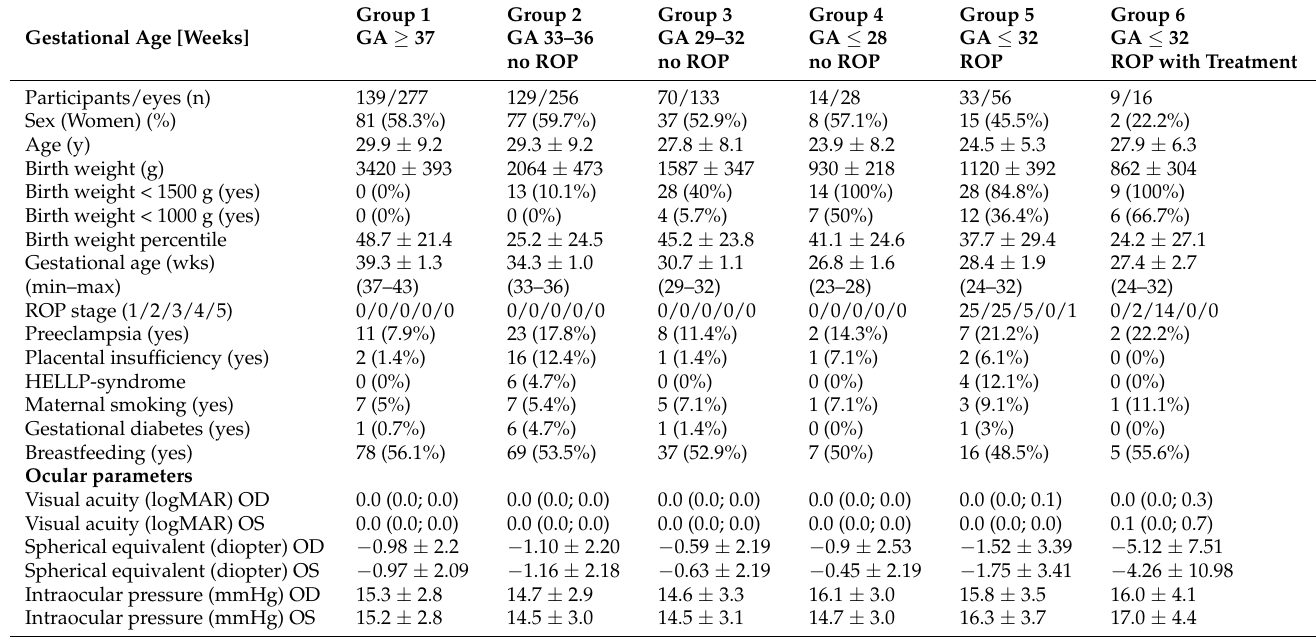
Table 1. Characteristics of the sample of the Gutenberg Prematurity Eye Study stratified by study